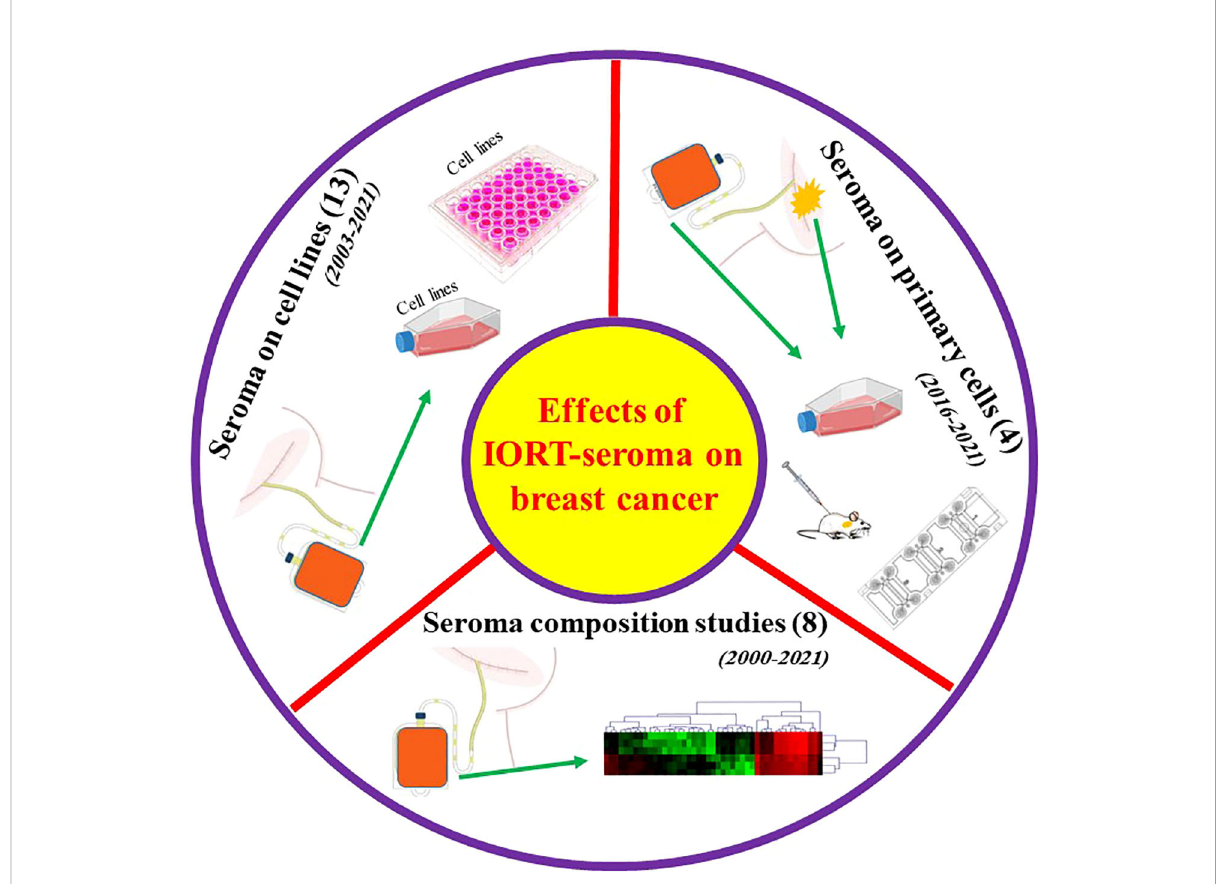
FIGURE 3 Graphical abstract for performed studies in breast surgery IORT- and non-IORT-seroma and their effects on breast cancer.